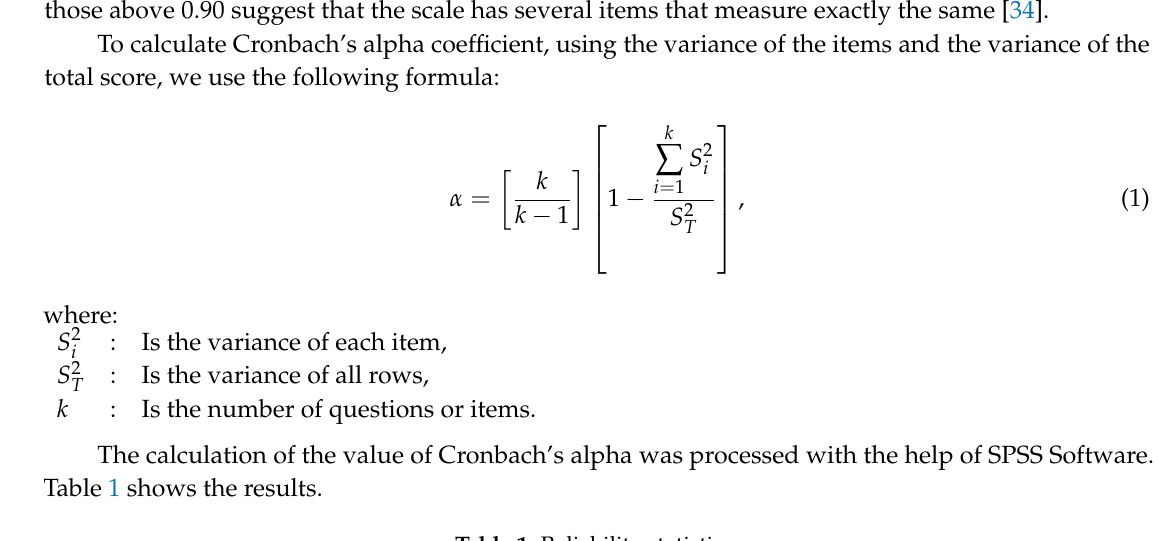
Table 1. Reliability